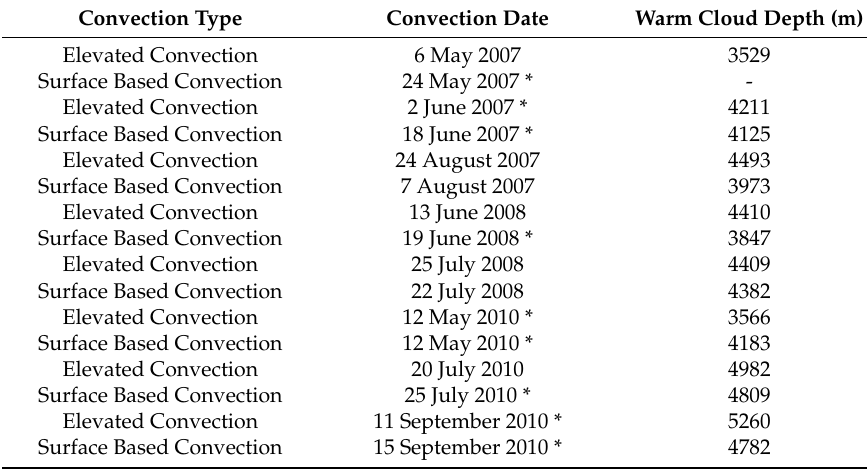
Table 7. Warm cloud depth (m) for all convection cases. An asterisk (*) indicates that atmospheric blocking was present in the Pacific Region (140 ◦ E–100 ◦